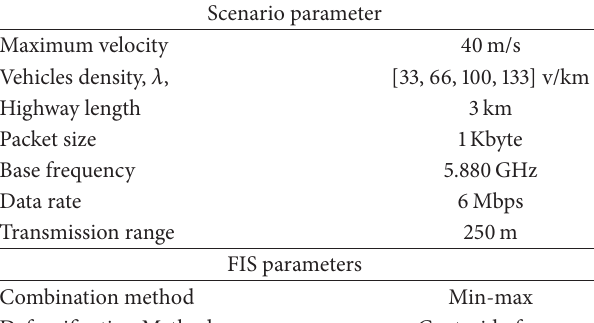
Table 2: Values used for each variable in the simulation scenario.